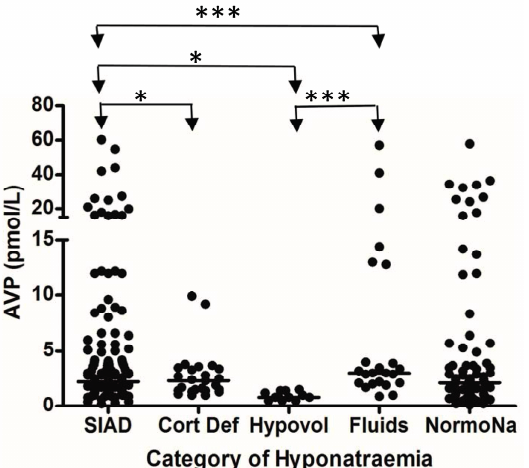
Figure 2. Comparison of AVP levels between different patient groups in patients with hyponatremia following SAH; each point represents an individual AVP measurement; adapt from [6] with permission.